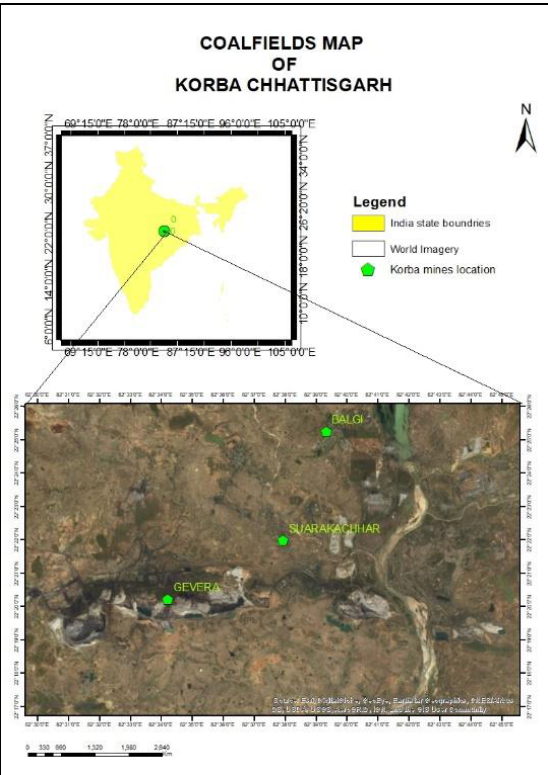
Figure 1 Coalfields of Korba,